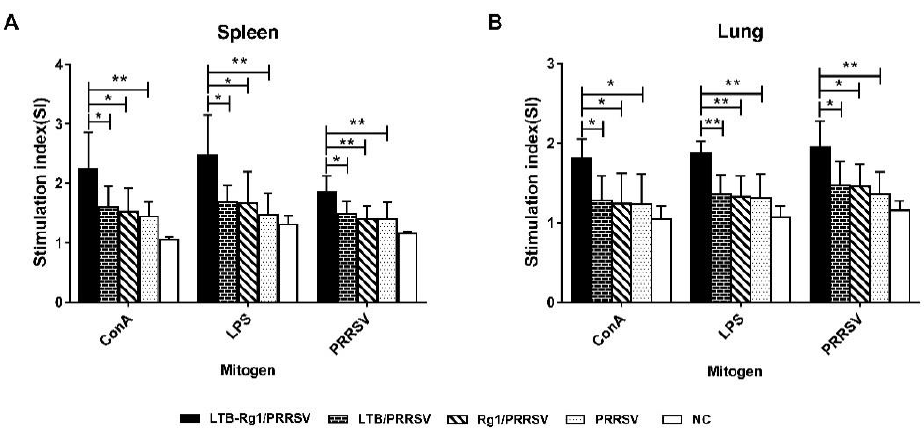
Figure 5. LTB-Rg1 significantly enhanced lymphocyte proliferative response to ConA, LPS, and PRRSV antigen. Mice ( n = 6/group) were immunized intranasally with PRRSV vaccine combined with saline, LTB, Rg1, or LTB-Rg1. Non-immunized mice served as negative controls. Splenocytes and lung mononuclear cells were collected on day 35 and stimulated with ConA, LPS, or PRRSV antigen for 48h. ( A ) Splenocyte proliferation was determined using CCK-8. ( B ) The proliferation of lung mononuclear cells was measured. Stimulation index (SI) was calculated. Data are expressed as means ± SD. * p < 0.05, ** p < 0.01.